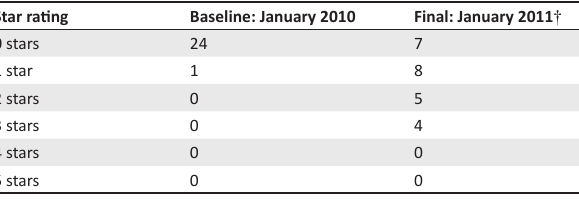
FIGURE 5: Average performance of all laboratories across the 12 sections, as measured by the World Health Organization Regional Headquarters for Africa Stepwise Laboratory Quality Improvement Toward Accreditation (WHO–AFRO– SLIPTA) TABLE 4 : Star rating of all laboratories between baseline and final assessments using the World Health Organization Regional Headquarters for Africa Stepwise Laboratory Quality Improvement Toward Accreditation (WHO–AFRO–SLIPTA) checklist.